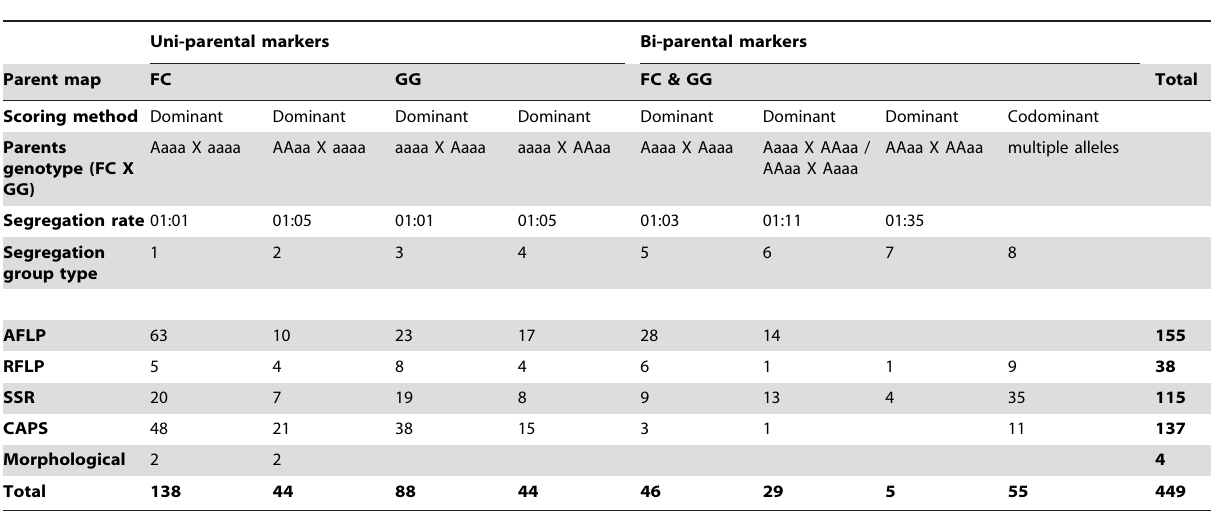
Table 1. The markers used to construct the rose